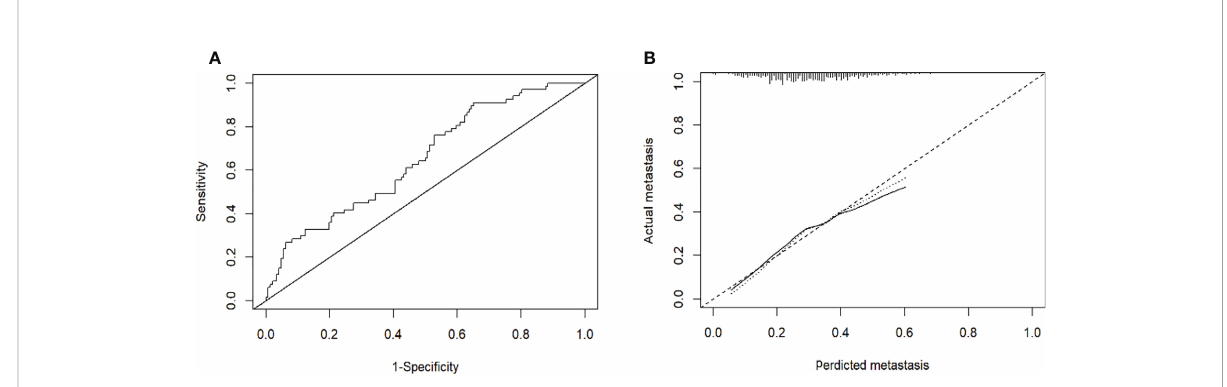
FIGURE 4 (A) : Receiver operating characteristic curves for EHM of the patients in the training cohort. The receiver operating characteristic curves at the initial diagnosis are shown, and its area ROC curves are provided. (B) : Calibration plots of EHM in the training cohorts. The calibration curves derived from the training cohorts are almost a diagonal line that would represent perfectly reliable